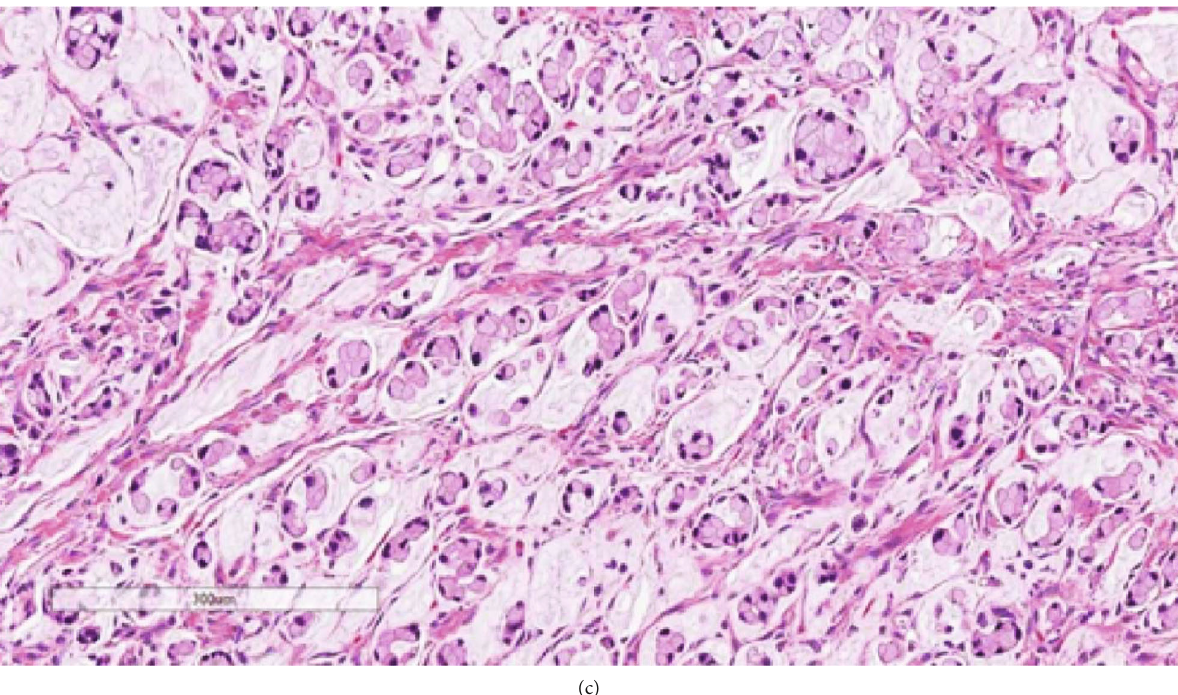
Figure 1: The tumor predominantly consists of signet ring cells fl oating in mucinous substance (hematoxylin and eosin staining; magni fi cation: (a) × 40 and (b, c) ×